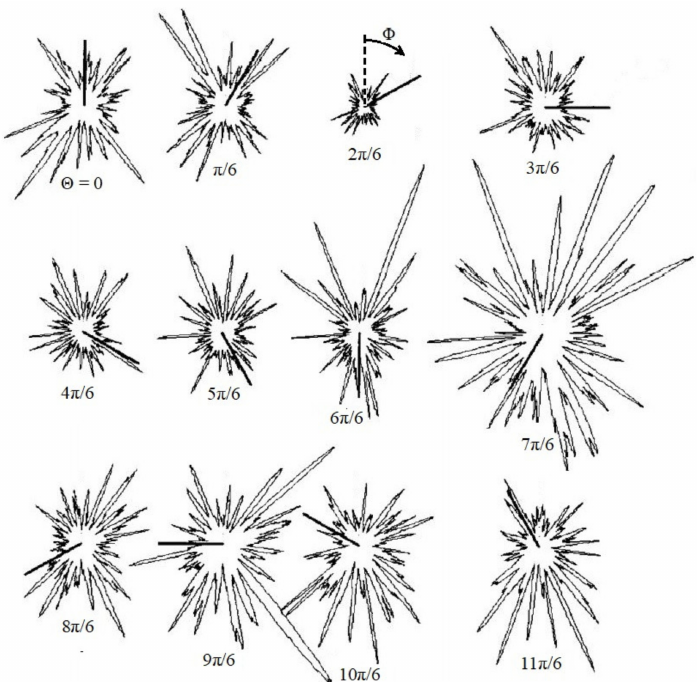
Figure 4. An illustration of I (